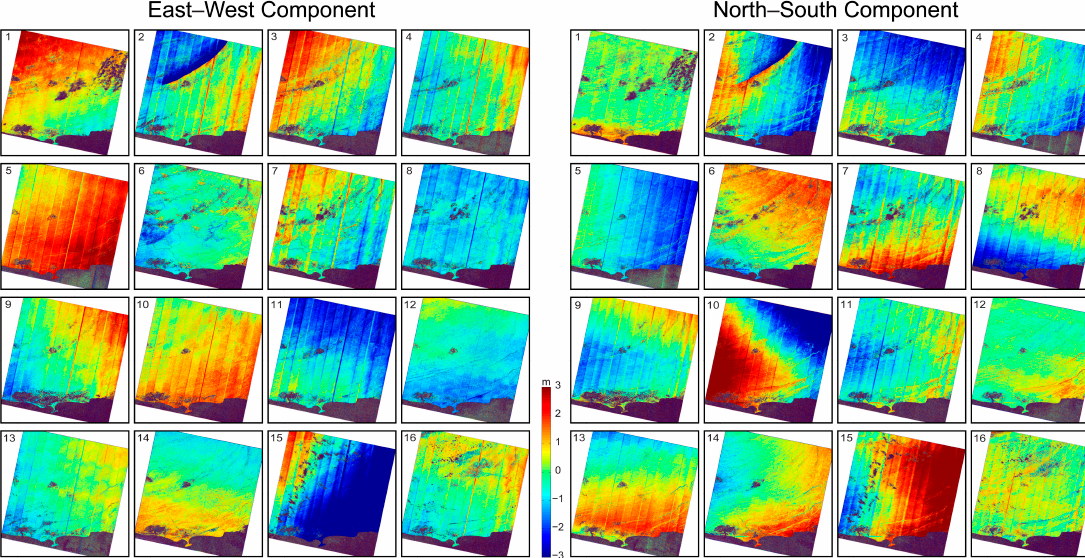
Figure 2. E/W and N/S components of image deformation fields. The serial numbers of all sub-graphs correspond to correlation image pairs in Table 1. Displacements are positive toward the East and North in this and following figures.